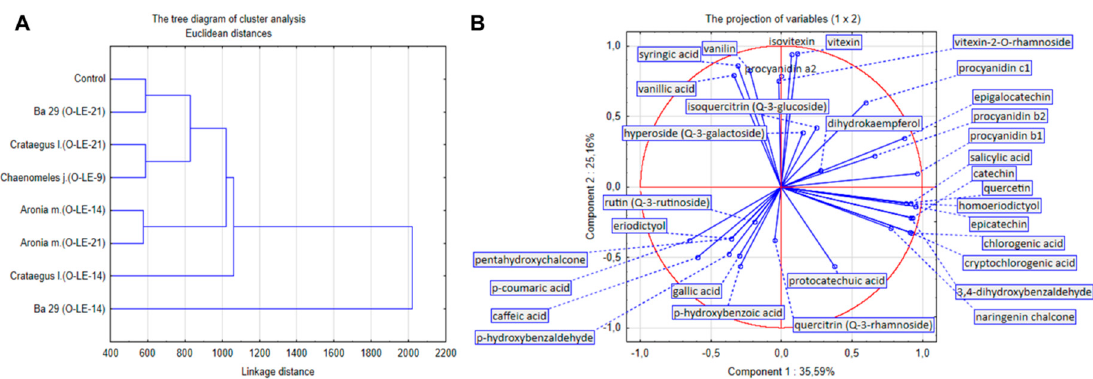
Figure 4. ( A ) The tree diagram of cluster analysis for 8 groups (samples) based on 33 variables (anti-oxidative compounds). Single-linkage clustering with Euclidean distances was used; ( B ) the Principle Component Analysis (PCA) projection of variables (anti-oxidative compounds) into a plane consisted of PCA components 1 and 2. The PCA component 1 represents 35.59% of the total data variability. The component 2 represents 25.16% of the total data variability. The data for statistics are shown in the supplementary material (Tables S1 and S2).